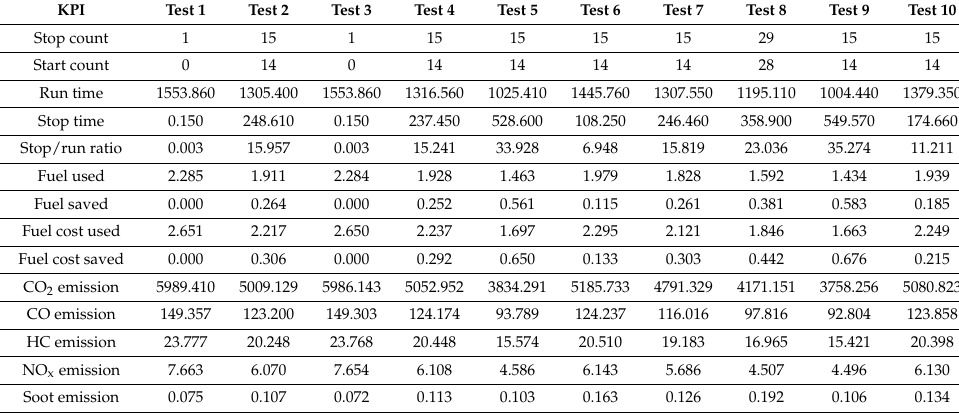
Table 7. Summary of the PISSC-based ICE performances with respect to 10 random test cases after 14